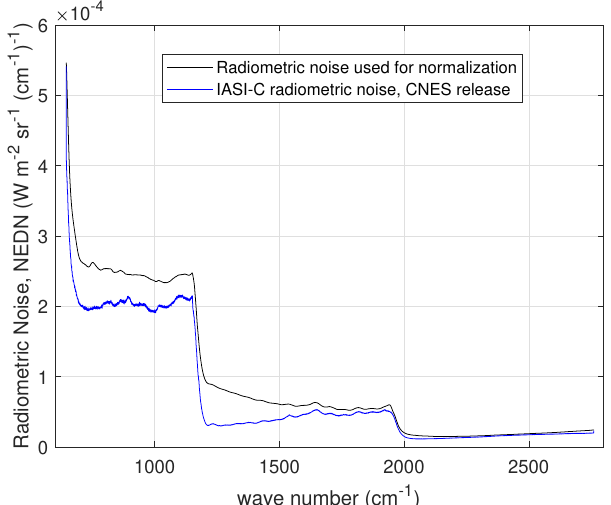
Figure 5. Diagonal of the normalizing matrix ˜ S ε used for IASI and comparison with the IASI-C nominal radiometric noise in units of NEDN (W-m − 2 sr − 1 (cm − 1 ) − 1 ) (also shown in Figure